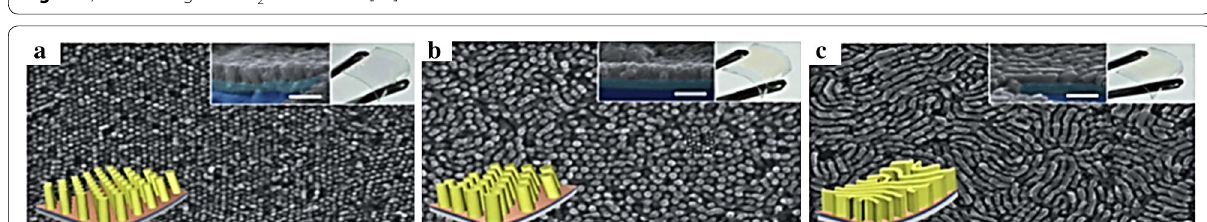
Fig. 8 a , b TEM images of Cu 2 O nanowires [56]